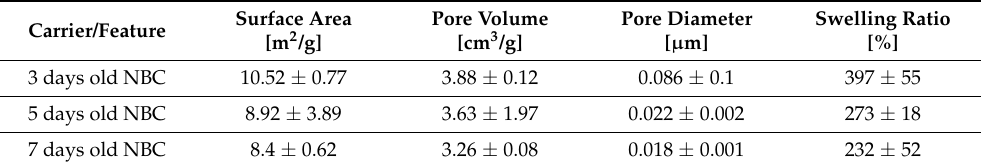
Table 1. NBC carriers (3, 5 and 7 days old)